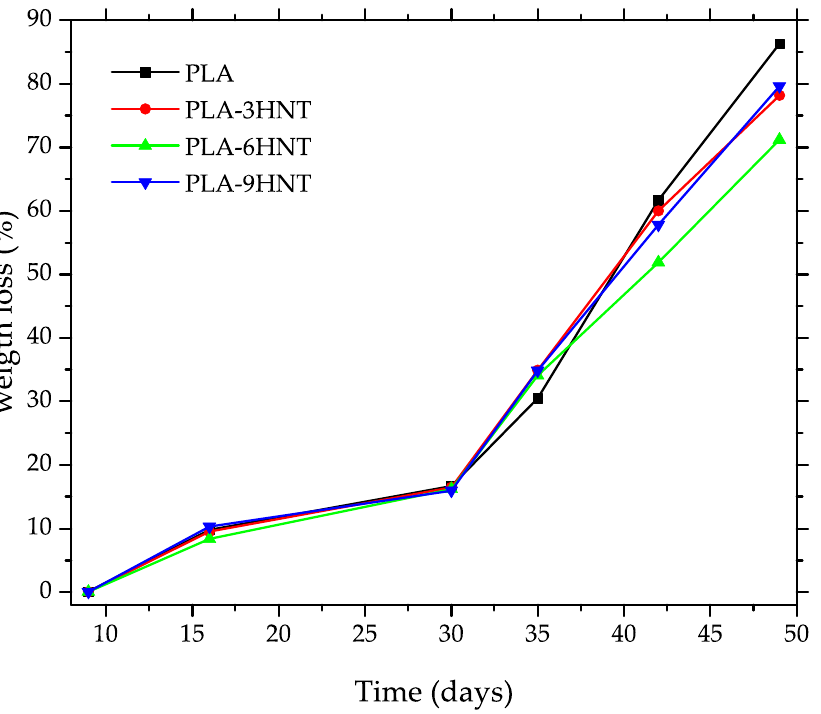
Figure 9. Follow up of the disintegration process in controlled compost soil of PLA-HNTs composites with different HNTs loading.